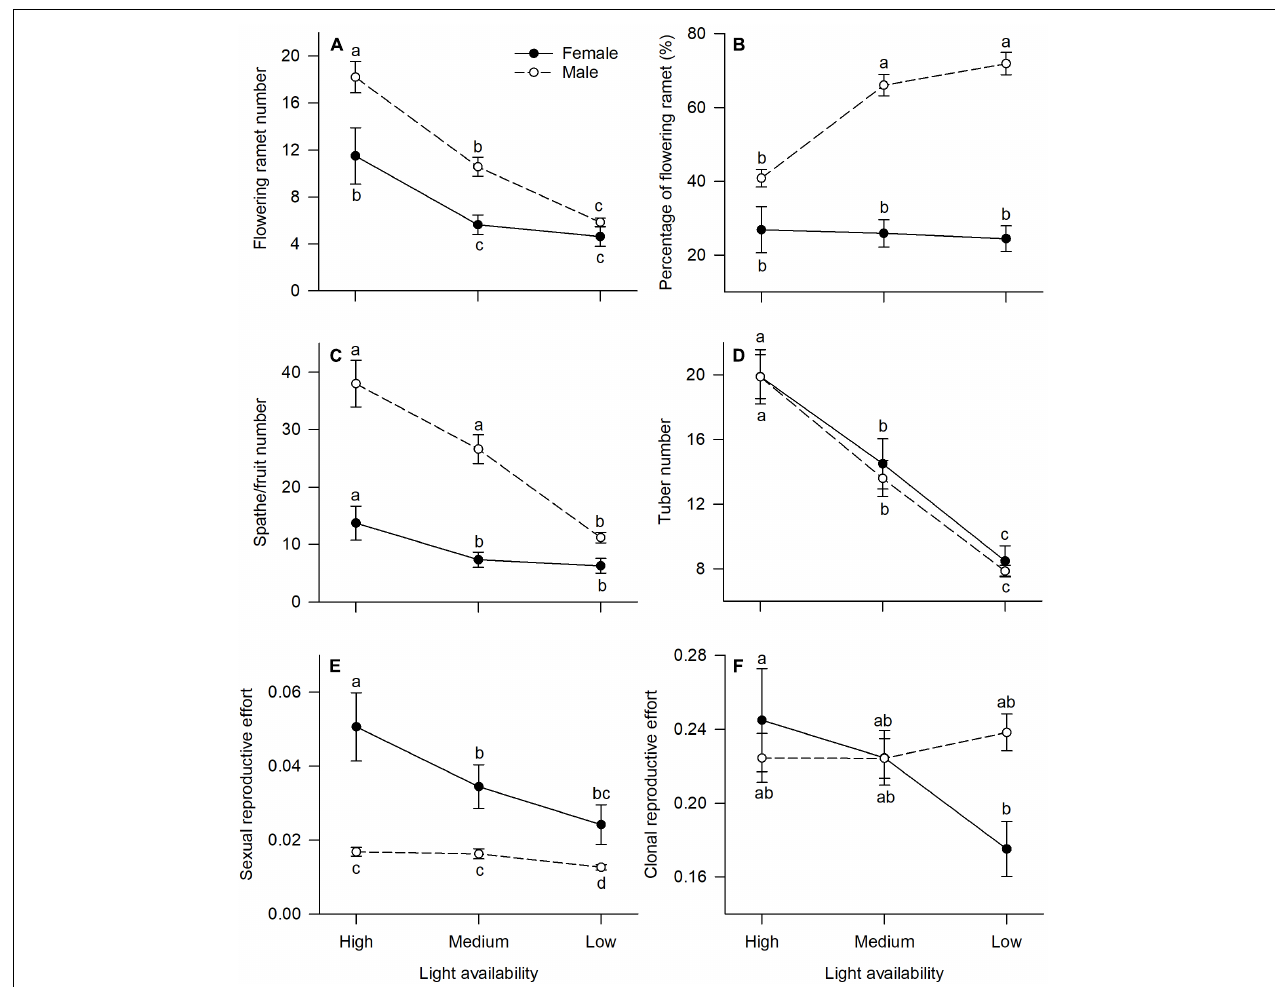
FIGURE 2 | Effects of light availability on allocation to reproductive tissues for males and females of V. spinulosa at reproductive maturity: (A) flowering ramet number, (B) percentage of flowering ramet, (C) spathe/fruit number, (D) tuber number, (E) sexual reproductive effort, and (F) clonal reproductive effort. For each individual sexual and clonal reproductive efforts were calculated as the ratio between dry mass of the respective tissues (male: spathes; female: fruits) and total biomass. Letters denote significant difference ( P < 0.05), using Tukey HSD comparisons. Error bars show ± SE. Curves are usually used to display differences between sexes under different environmental conditions (Harris and Pannell, 2008; Hesse and Pannell,